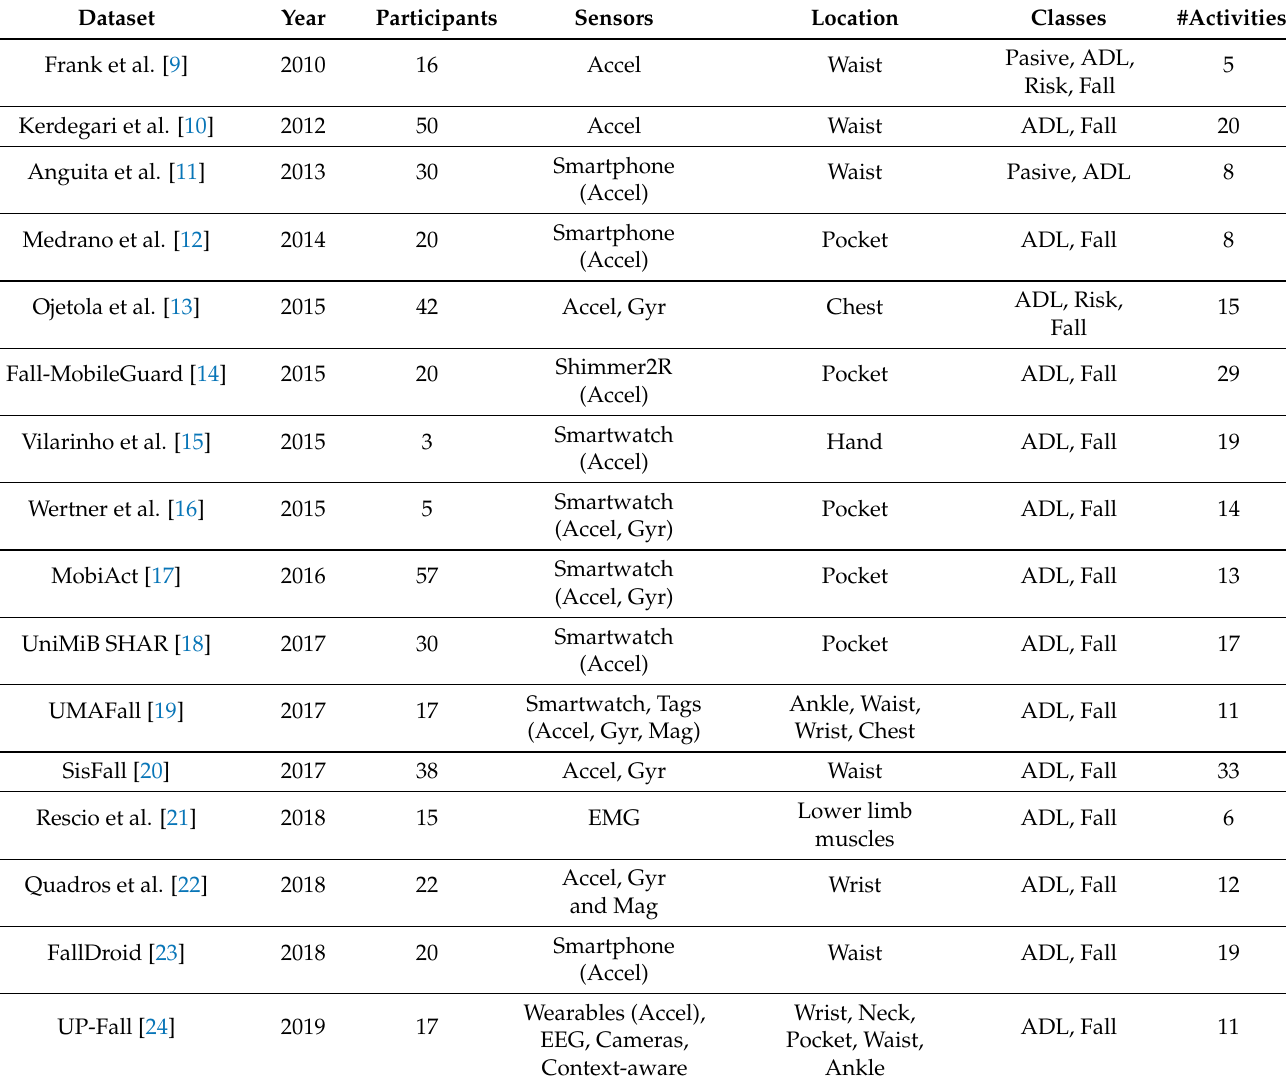
Table 1. Datasets